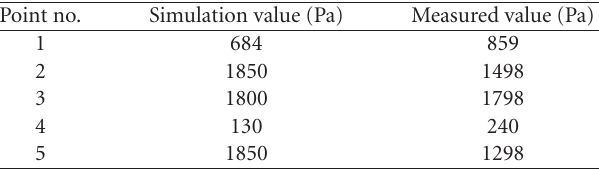
Figure 20: Static pressure distribution on suction side of a fan blade with radiator (unit in Pascal). Table 3: Comparison of static pressure at selected locations. Point no.